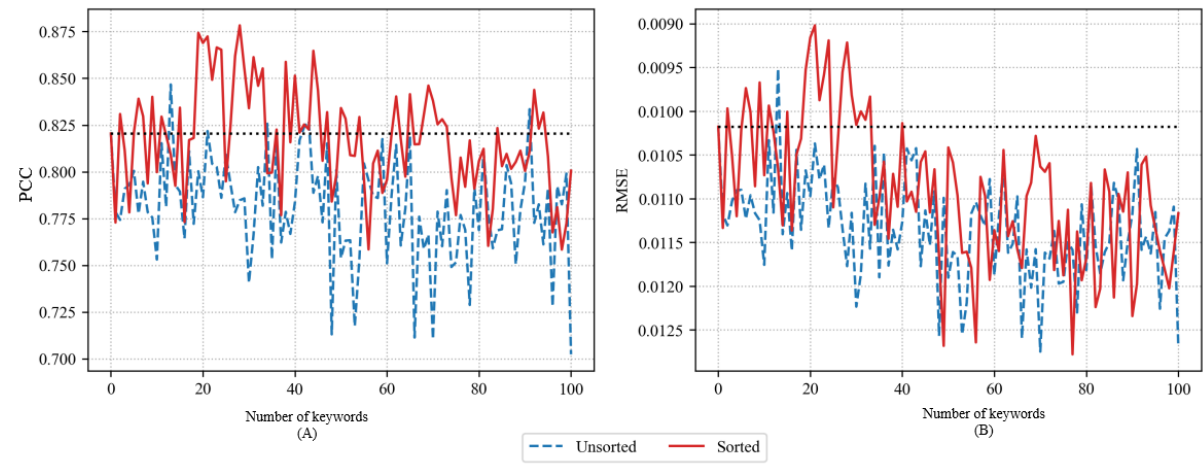
Figure 4. Pearson correlation coefficient (PCC) (A) and root-mean-square error (RMSE) (B) of long short-term memory models using GloVe.